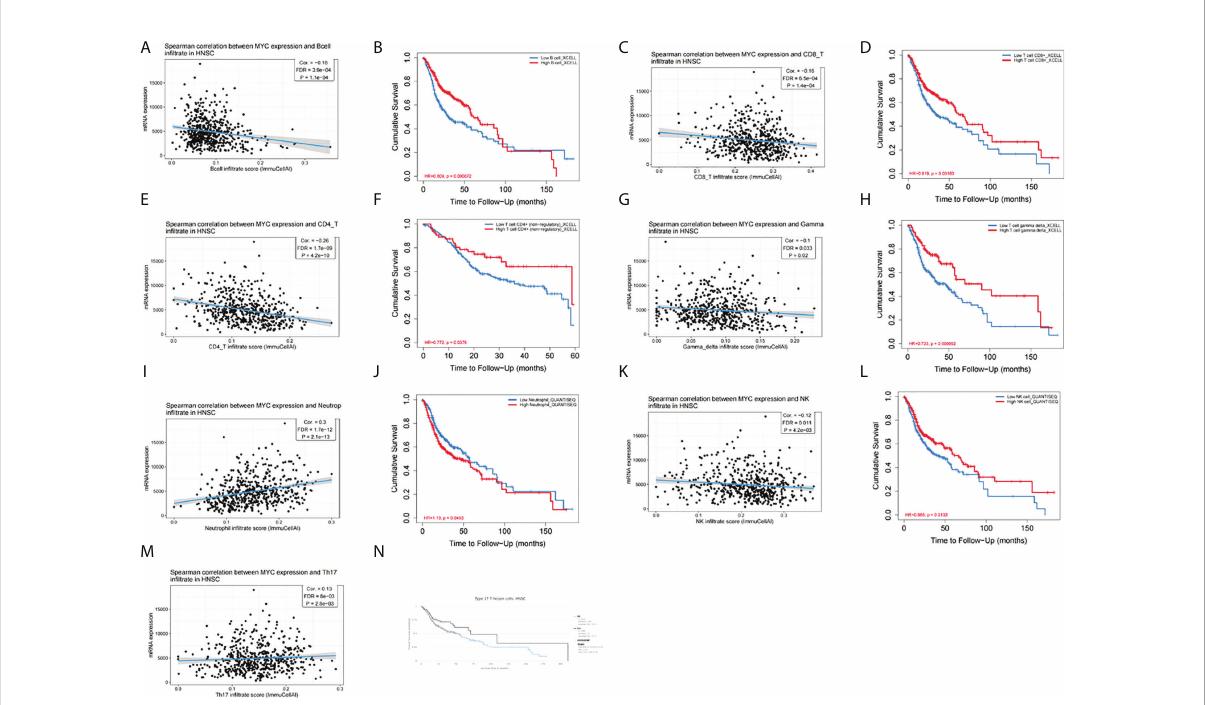
FIGURE 5 c-Myc expression is correlated with immune in fi ltration of (A) B cells, (C) CD8+ T cells, (E) CD4+ T cells, (G) gamma delta T cells, (I) neutrophils, (K) NK cells, and (M) Th17 cells. Tumor-in fi ltrating immune cells were associated with OS (B, D, F, H, J, L, N)